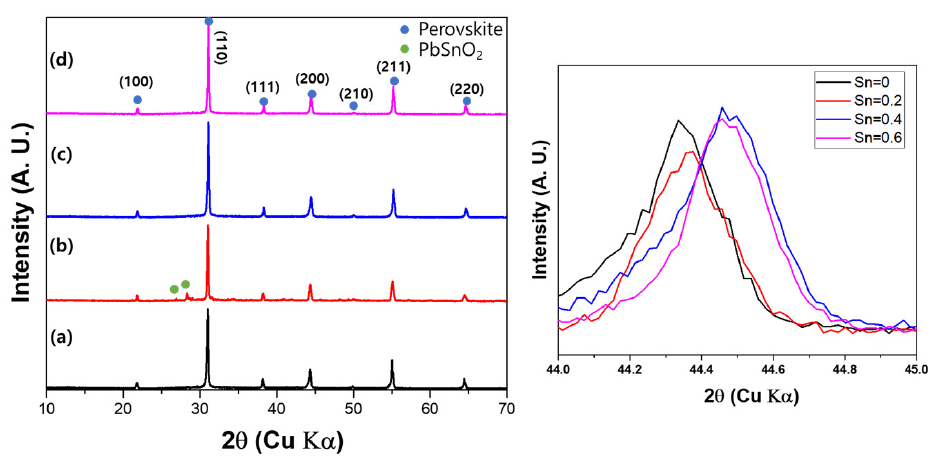
Figure 5. Crystal structures of (Pb 0.88 , La 0.12 )(Zr 1 − x , Sn x ) 0.86 Ti 0.14 O 3 composition according to the substitution of Sn 4+ ( a ) Sn = 0, ( b ) Sn = 0.2, ( c ) Sn = 0.4, ( d ) Sn = 0.6.